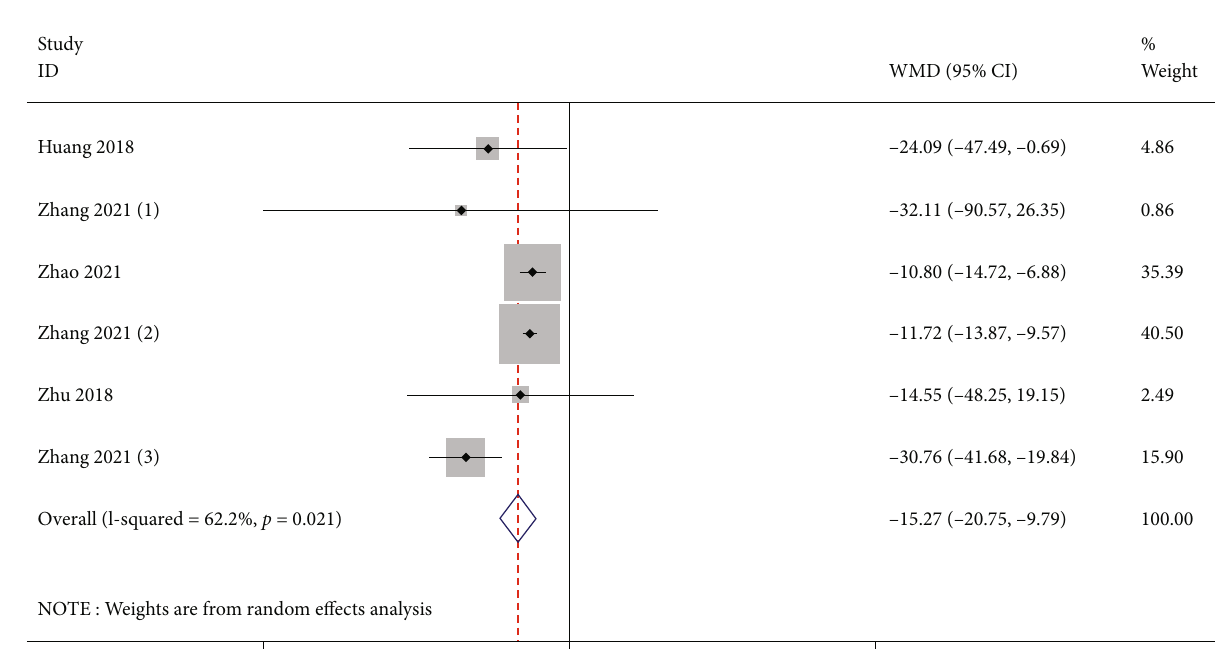
Figure 4: Forest illustration of the EGFR.